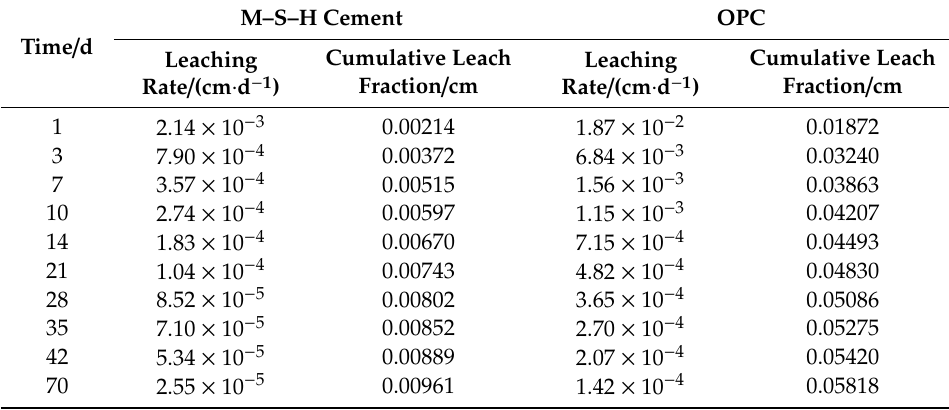
Table 5. Leaching rate and cumulative leach fraction of different cement-solidified bodies.